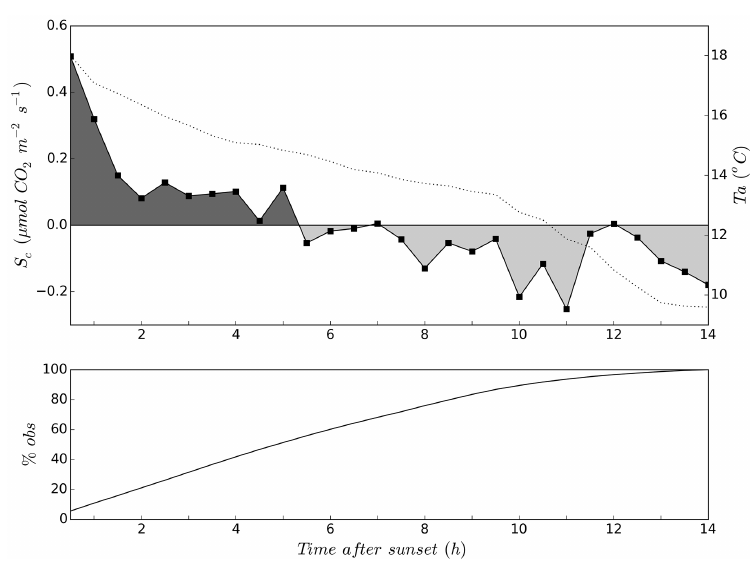
Figure 14. Dependence of S c (including only data where u ∗ >u ∗ th ) on time after sunset (upper panel, dotted line is air temperature); cumulative percentage of total nocturnal S c observations (lower